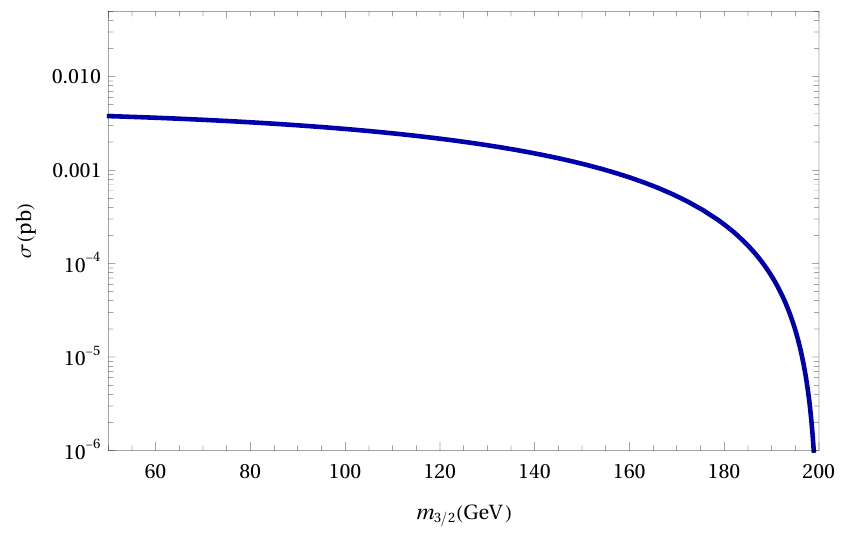
Figure 2 . The production cross section of spin-3/2 particles in the point-like processes e + e − → √ ¯ ν e + ψ ψ ν e at LEP2 energies, s = 200 GeV, as a function of the mass m 3 / 2 3 / 2 the effective Hamiltonian parameters Λ = 1 TeV and c l = 1